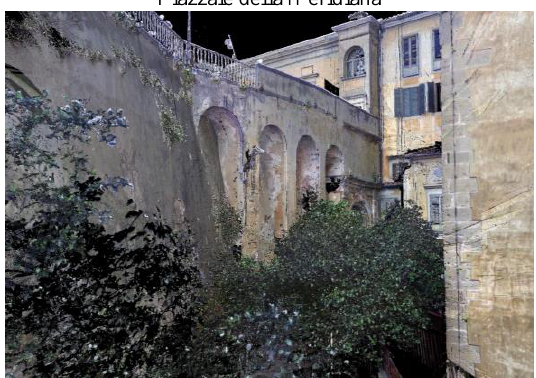
Figure 6. Point cloud, detail of the upper retaining